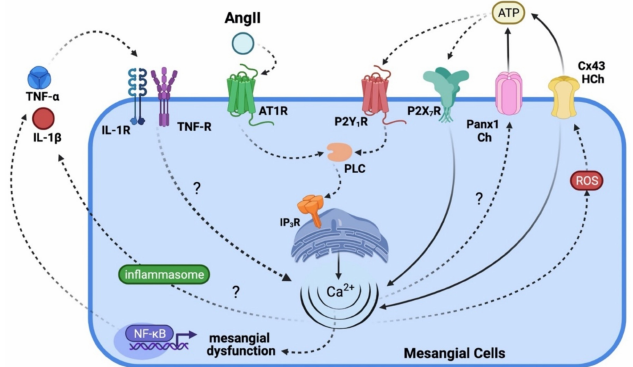
Figure 5. Scheme of possible signaling pathways involved in regulating of Cx43 hemichannels and Panx1 channels in mesangial cells stimulated with AngII. High AngII concentrations (10 − 7 M) activate angiotensin type 1 receptors (AT1R) in MCs, causing the PLC-mediated stimulation of IP3 receptors and further release of Ca 2+ stored in the endoplasmic reticulum, NF- κ B-dependent release of proinflammatory cytokines such as TNF- α and IL-1 β , as well as the formation of reactive oxygen species (ROS). The resulting increase in [Ca 2+ ] i can also stimulate Panx1 channels and Cx43 hemichannels, eliciting the subsequent release of ATP to the extracellular compartment. Then, ATP activates P2X 7 and P2Y 1 receptors that, together with Cx43 hemichannels, permit a drastic increase in Ca 2+ influx. As already seen in other systems, the increase in [Ca 2+ ] i promotes the expression and release of pro-inflammatory cytokines such as TNF- α , IL-1 β via the activation of the inflammasome, and the generation of ROS. The release of ATP and influx of Ca 2+ establish a positive feedback loop. Of note, alterations in [Ca 2+ ] i homeostasis mediated by Cx43 hemichannels or Panx1 channels could affect diverse aspects of MCs function (e.g., morphology and pro-inflammatory profile). Solid lines depict fluxes of molecules through channels, whereas dashed lines indicate activation or induction. Elaborated in BioRender.com (accessed on 15 October